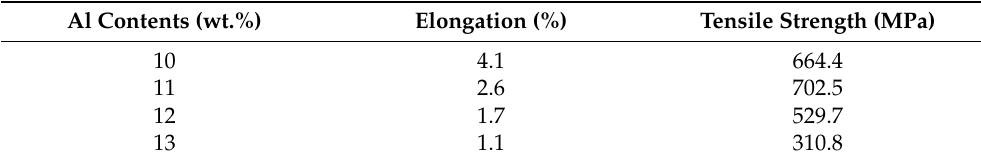
Table 3. Elongation and tensile strength of Fe-25Mn- x Al-8Ni-C alloy with different Al contents. Al Contents (wt.%)